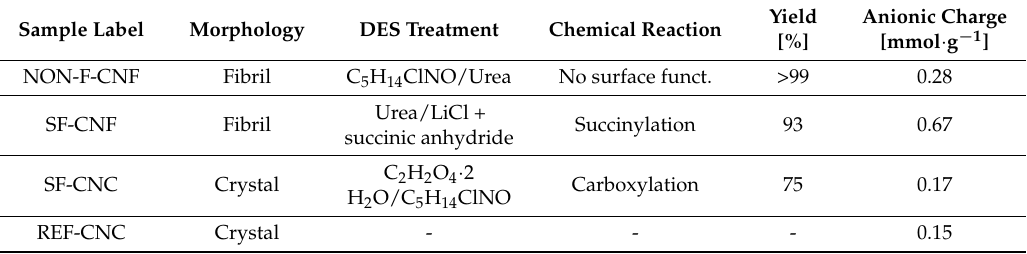
Figure 4. The carboxylation reaction of cellulose in choline chloride-oxalic acid (dihydrate) DES. Table 1. Cellulose nanoparticles production with DES pre-treatment, particle morphology, surface functionality, yield after pre-treatment, and carboxyl